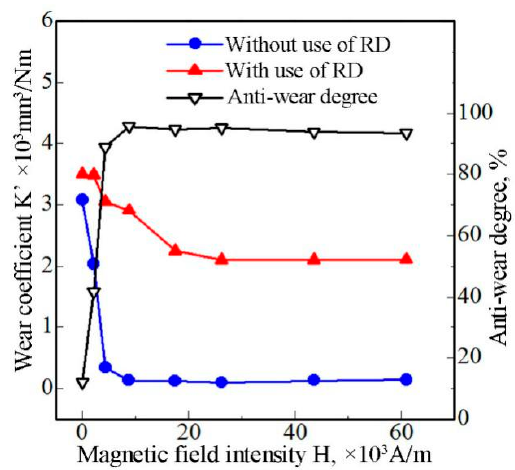
Figure 19 Wear coefficient and anti-wear degree. Figure 19. Wear coefficient and anti-wear